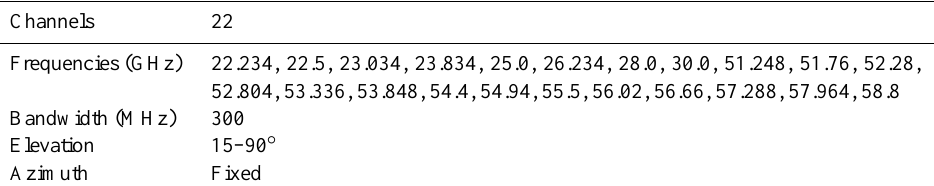
Table 1. Summary of MWRP characteristics.